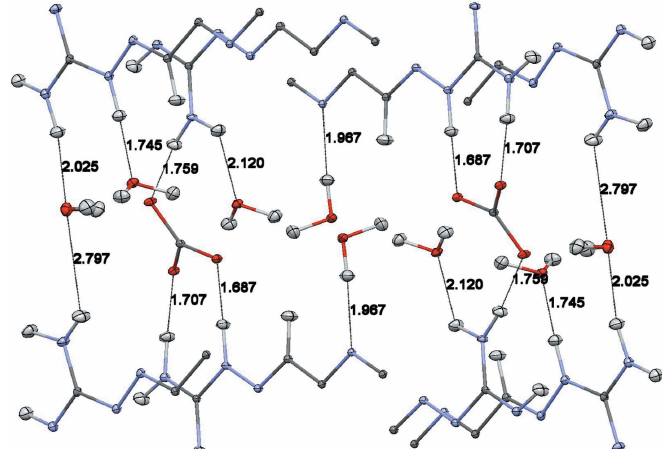
Figure 4 Potential hydrogen bonds between the anion–water ribbon and neighboring cations. All cations have been truncated to enhance the visibility of the hydrogen bonds. The figure is based on the neutron structure, with displacement ellipsoids drawn at the 20% proabability level and distances in A˚ (Macrae et al. , 2008). Color scheme: oxygen, red; nitrogen, blue; carbon, dark gray; hydrogen, light